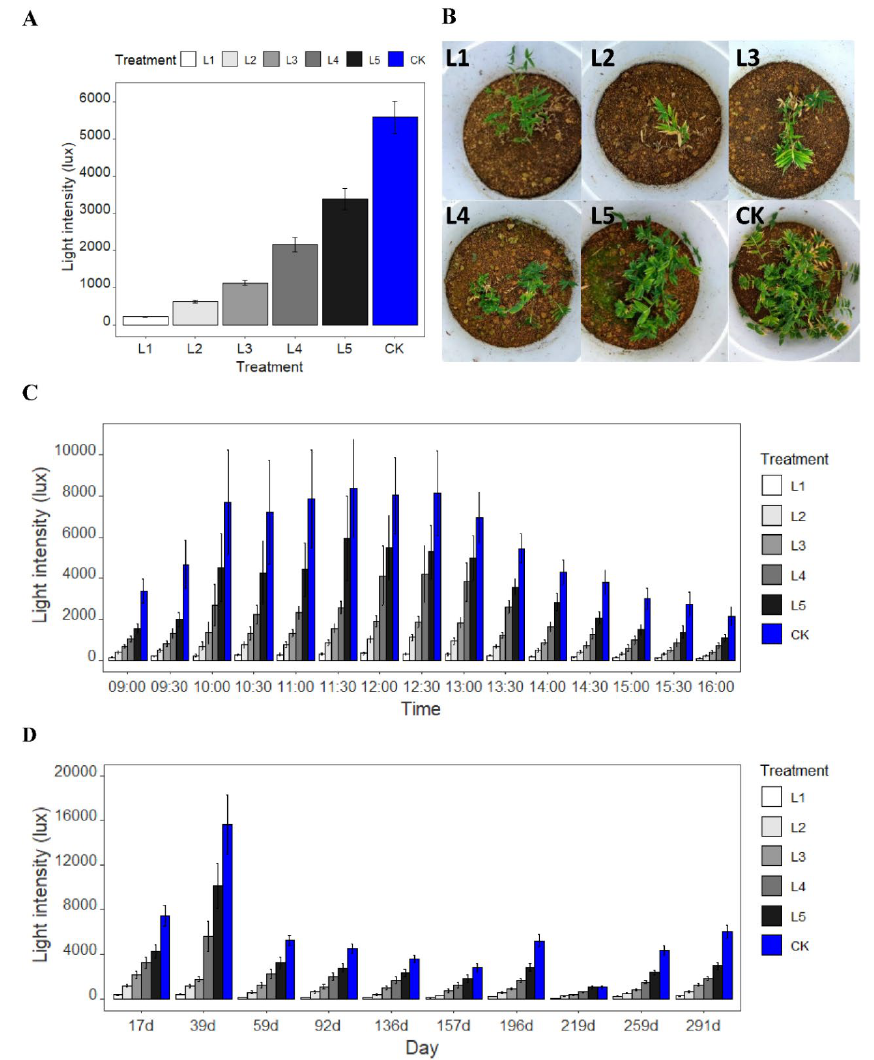
Figure 1. The plots of ( A ) mean light intensity under six light levels; ( B ) typical phenotype of P. pygmaeus on November 30, 2016; ( C ) diurnal variation of light intensity under six light levels; ( D ) light intensity along the investigation time under six light levels. The average light intensity of different treatments is L1 = 3.87%, L2 = 11.25%, L3 = 20.25%, L4 = 38.76%, L5 = 60.70%, and CK = 100% of full